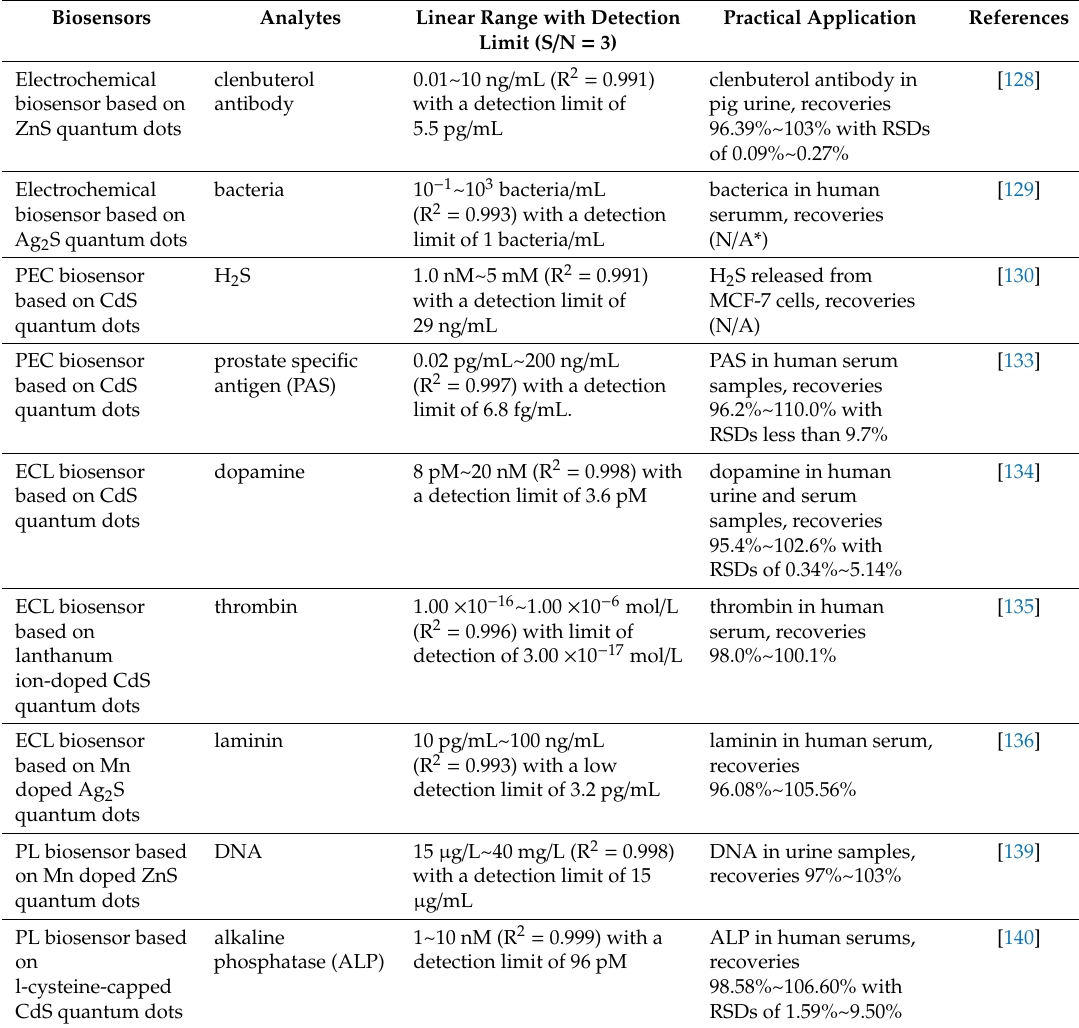
Table 3. Properties of biosensors based on sulfur-containing quantum dots listed